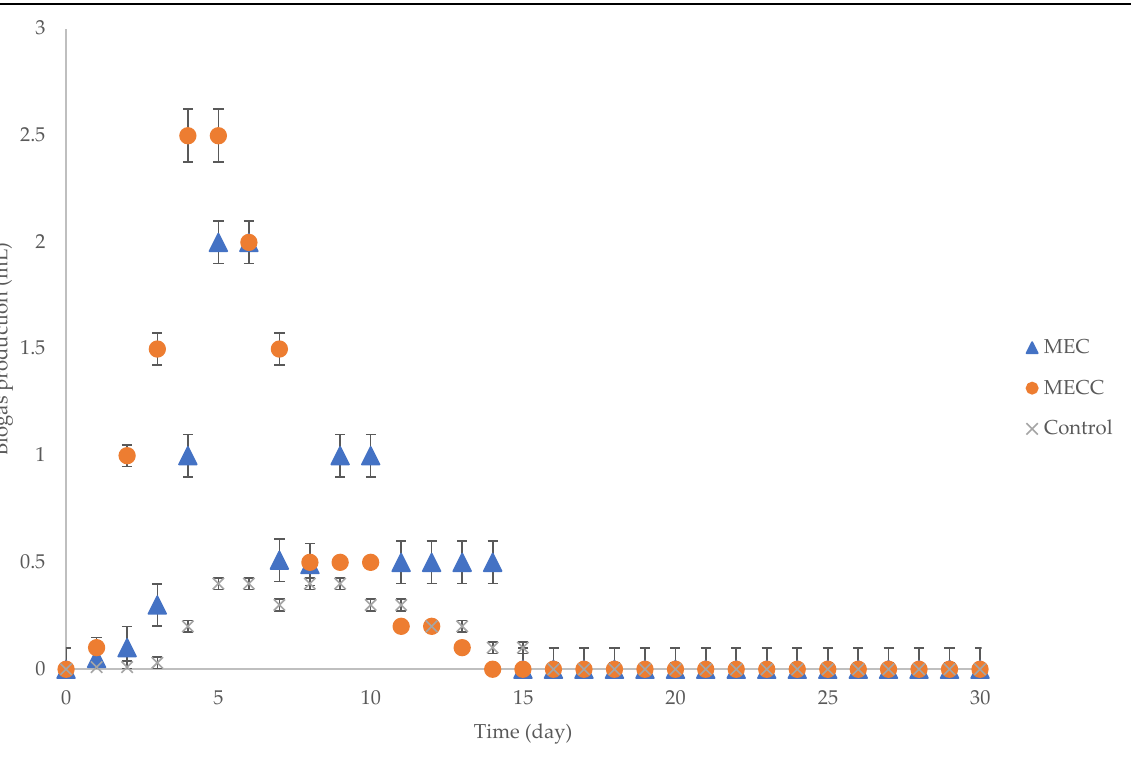
Table 1. Methane composition and methane conversion rate.